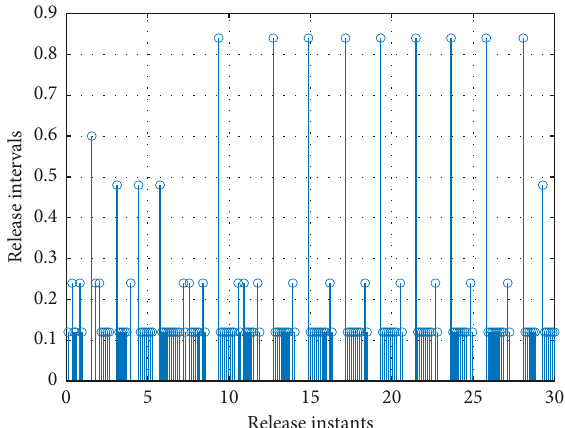
Figure 9: Release instants and time intervals.